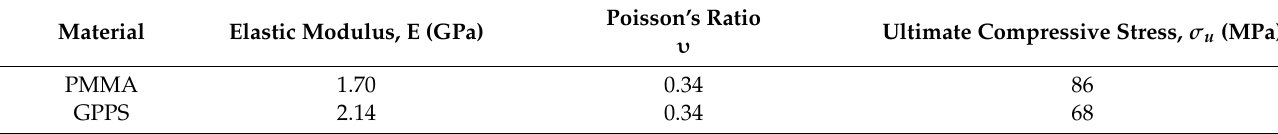
Table 1. Mechanical properties of the tested polymers under compression.